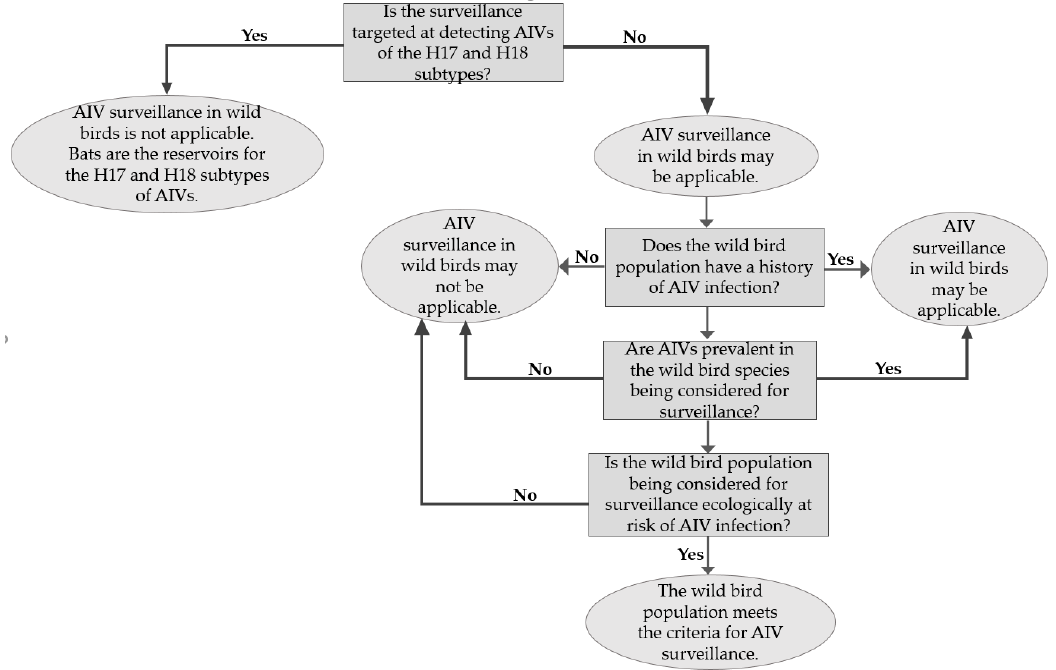
Figure 1. A flowchart representation of the criteria for selecting a wild bird population for avian influenza virus (AIV) surveillance.